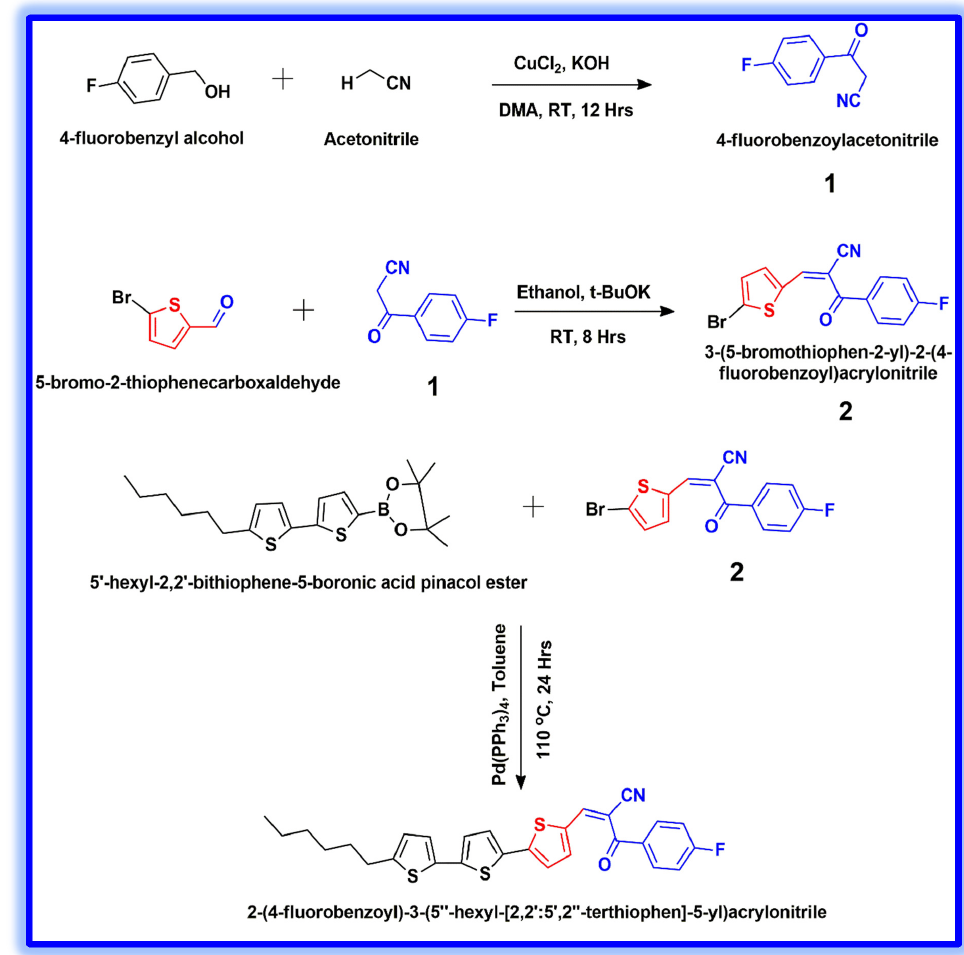
Scheme 1. The synthetic route for 2-(4-fluorobenzoyl)-3-(5”-hexyl-[2,2 (cid:48) :5 (cid:48) ,2”-terthiophen]-5-yl) acrylonitrile (H3T-4-FOP) small organic molecule